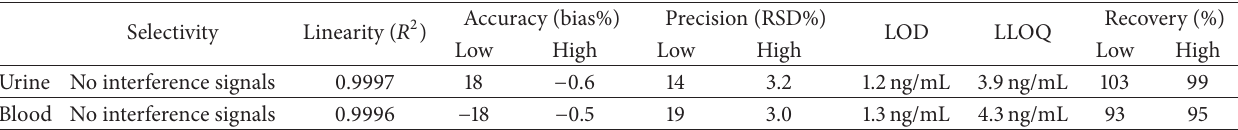
Table 1: Method validation parameters and